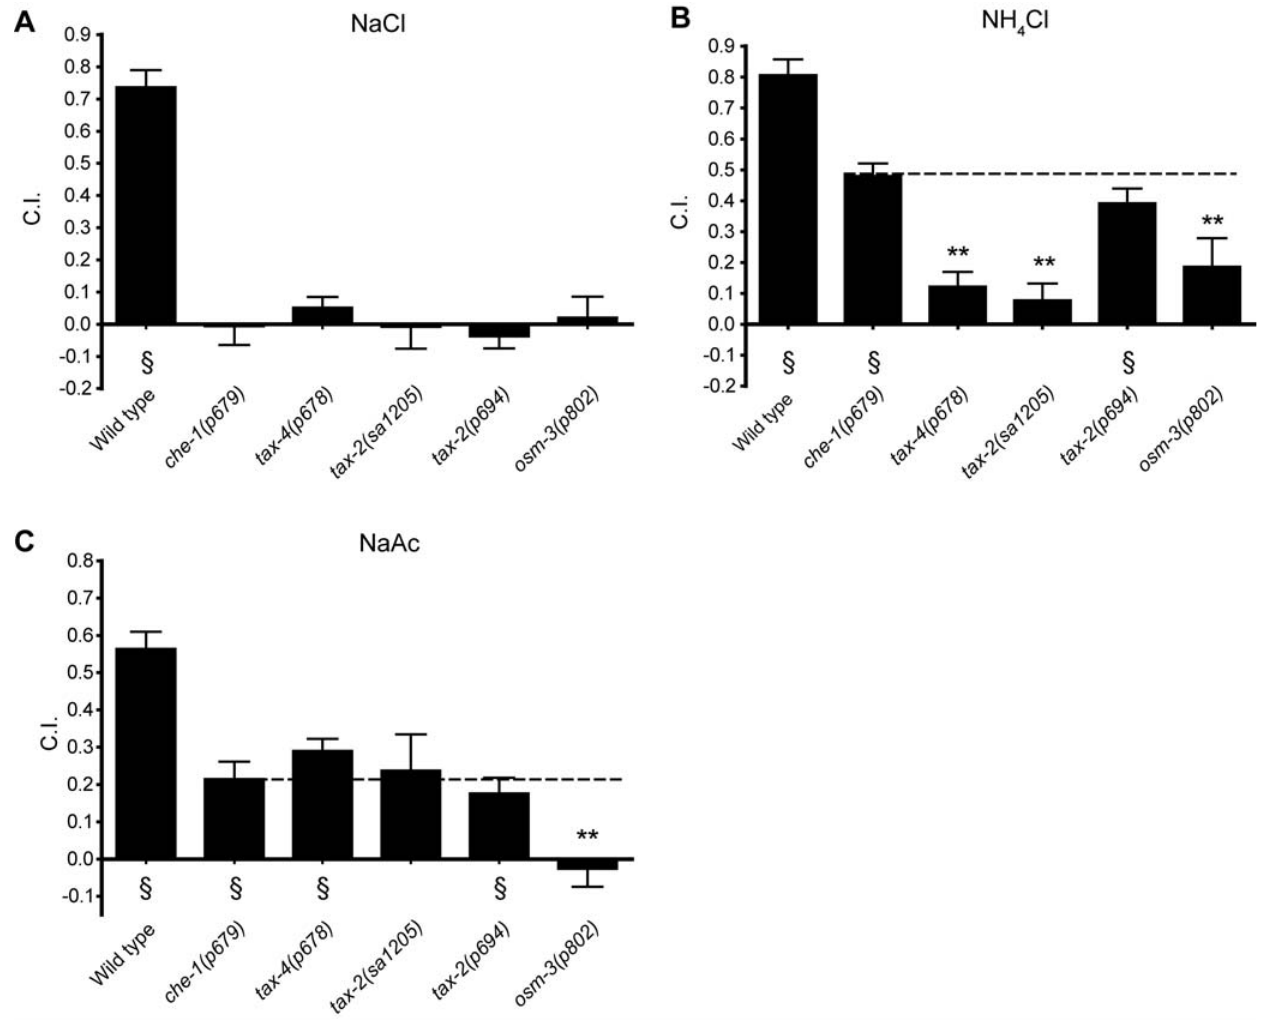
Figure 3. Genetic analysis of ammonium and acetate signal transduction pathways. (A–C) Water soluble chemotaxis assays for NaCl, NH 4 Cl, and NaAc. In each case, radial gradients of attractant were established by diffusion in the agar. Each bar represents the mean of at least 4 independent assays. Statistics: * p , 0.05 and ** p , 0.01 in a one-way ANOVA and Dunnet’s post test comparing all mutants to the che-1 (p679), which serves as a control in that it has normal chemotaxis to NH 4 Ac but no chemotaxis to NaCl; 1 p , 0.01 in a one sample t -test comparing the observed mean to a mean of